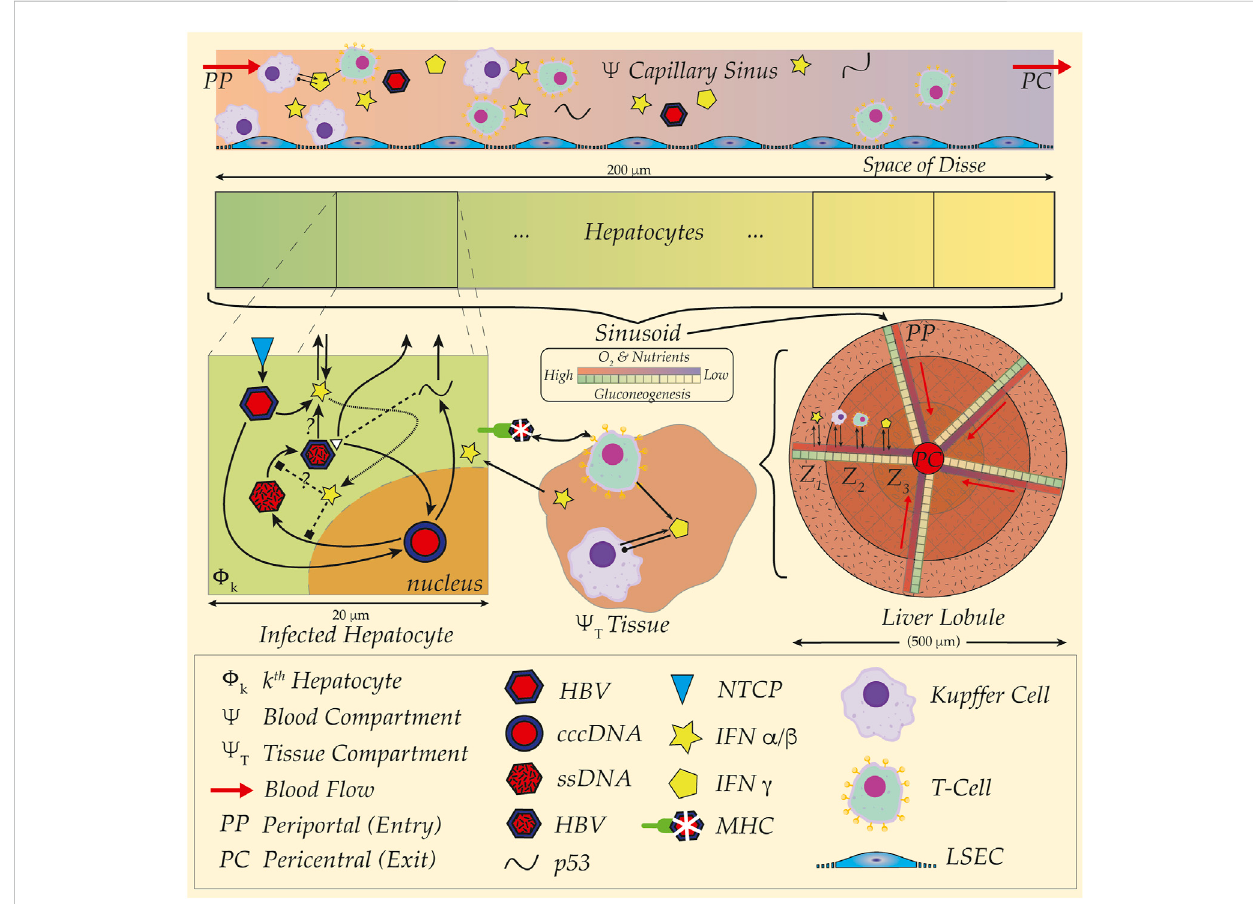
HBV and spatial organisation, distribution and structure of liver sinusoid. Cartoon schematic illustration of multiple spatial scales and organisation of liver from hepatocyte (20 um) up to sinusoid (200 um) and liver lobule (500 um). (Top Rows) Gradients of O 2 and nutrients represented in capillary sinus blood ( Ψ ) with colour gradient (red to blue) from Periportal (PP) to Pericentral (PC) site. Metabolic activity illustrated with colour gradient (green to yellow) for gluconeogenesis in hepatocytes. Note blood sinus populated with Kupffer Cells (purple), T-cells (green) as well as full HBV virus (red and blue hexagons), and representations of the immune cytokines interferon alpha/beta (IFN α / β , yellow star) and interferon gamma (IFN γ , yellow pentagon). Kupffer cells (KC) aggregate at the PP site for detection and capture of pathogens, further modulating downstream immune cell responses. Acinar assemblies of hepatocytes interface with materials transported to the Space of Disse by way of fenestrated liver sinusoidal epithelial cells (LSECs, low-pro fi le blue cells in sinus) — either passively fi ltered or actively bound and uptaken from proximal and slow blood fl ows at around 100 um/second. An example HBV infection dynamic is illustrated (Mid-Left, ‘ Infected Hepatocyte ’ ), where HBV invades hepatocyte via the NTCP transporter (blue diamond) and establishes cccDNA in the nucleus (red-blue circle). Viral proteins such as p53 and precursor viral DNA (ssDNA, mottled red hexagon) later assembled into full HBV virion and released back to sinus. Intracellular interactions with interferons illustrated with unknown potential modes of action, as well as presentation of viral sequences with the major- histocompatibility complex (MHC) to surveilling immune cells in the surrounding hepatic tissue (Region Ψ T ). Interferons and interleukins establish communications and source of coupling between compartments encompassing immune and endothelial cells either in tissue or in blood. Sinusoidal organisation of metabolic labour and immune cell aggregations arrayed according to said gradients within sinusoid including liver lobule zonation (Z 1 , Z 2 , Z 3 ); note radial arrangements of capillary sinuses emptying to the pericentral site with corresponding hepatocyte arrays (Liver Lobule, Mid-right). Outermost tissue region, Z 1 , with richest blood with corresponding highest gluconeogenesis and innermost, Z 3 , with most depleted, corresponding to particular metabolic activity, such as paracetemol processing. Individual transcription modulators such as the protein PGC1-alpha hijacked by HBV for viral DNA replication at higher levels of activity in PP region corresponding to elevated gluconeogenesis in the same region (see